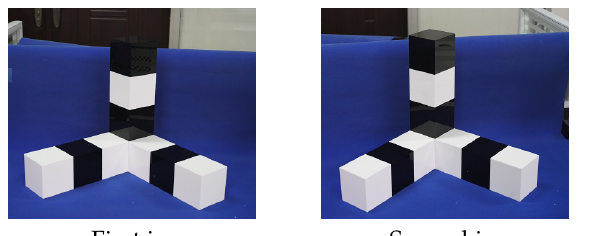
First image. Second image. Third image. Figure 4. Images of the first experiment.